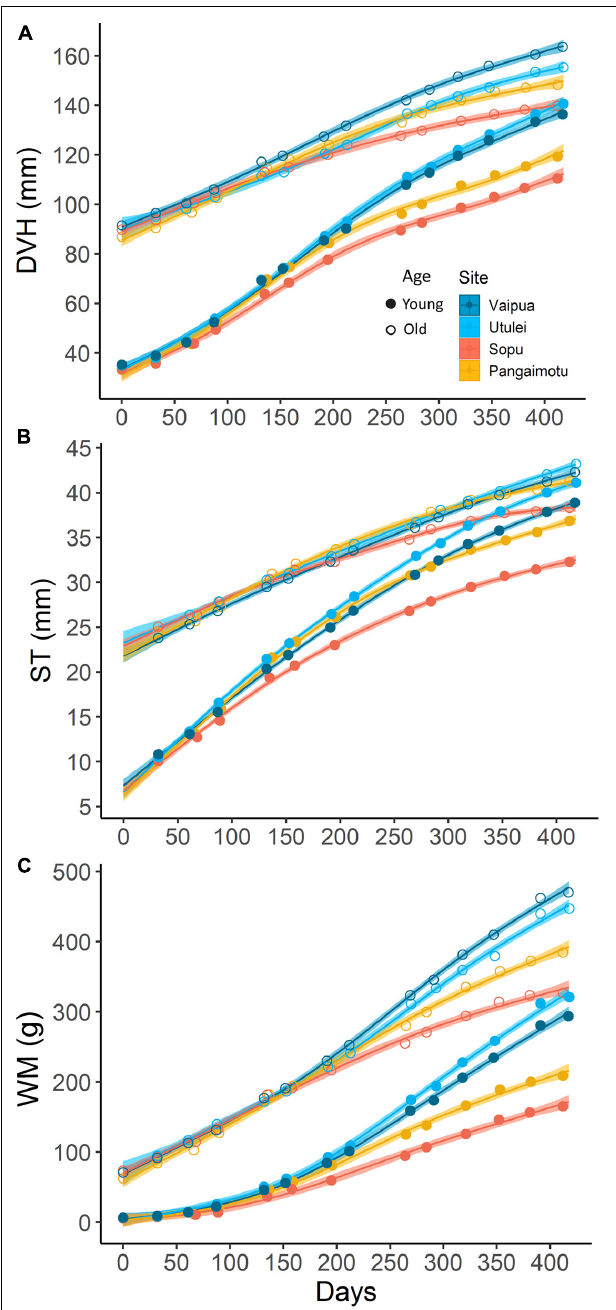
FIGURE 2 | Spatio-temporal variation in Pteria penguin shell dimensions over time: (A) dorso-ventral height (DVH); (B) shell thickness (ST): and, (C) wet mass (WM). Splines represent GAM model predictions ± 95% confidence intervals. Where one spline falls within the error envelope of another, there is no significant difference in mean measurements between those splines for that time period.